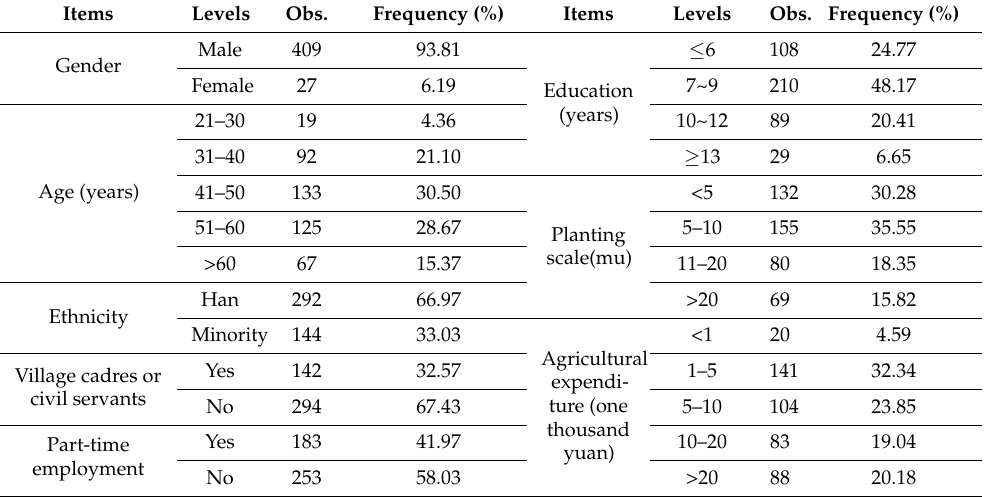
Table 1. Descriptive statistics of the sample